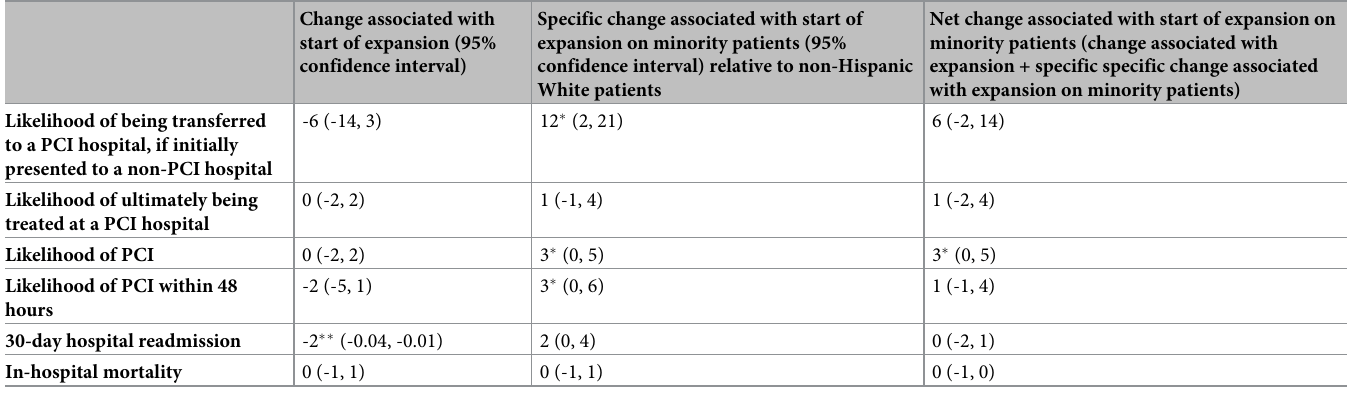
Net change associated with start of expansion on minority patients (change associated